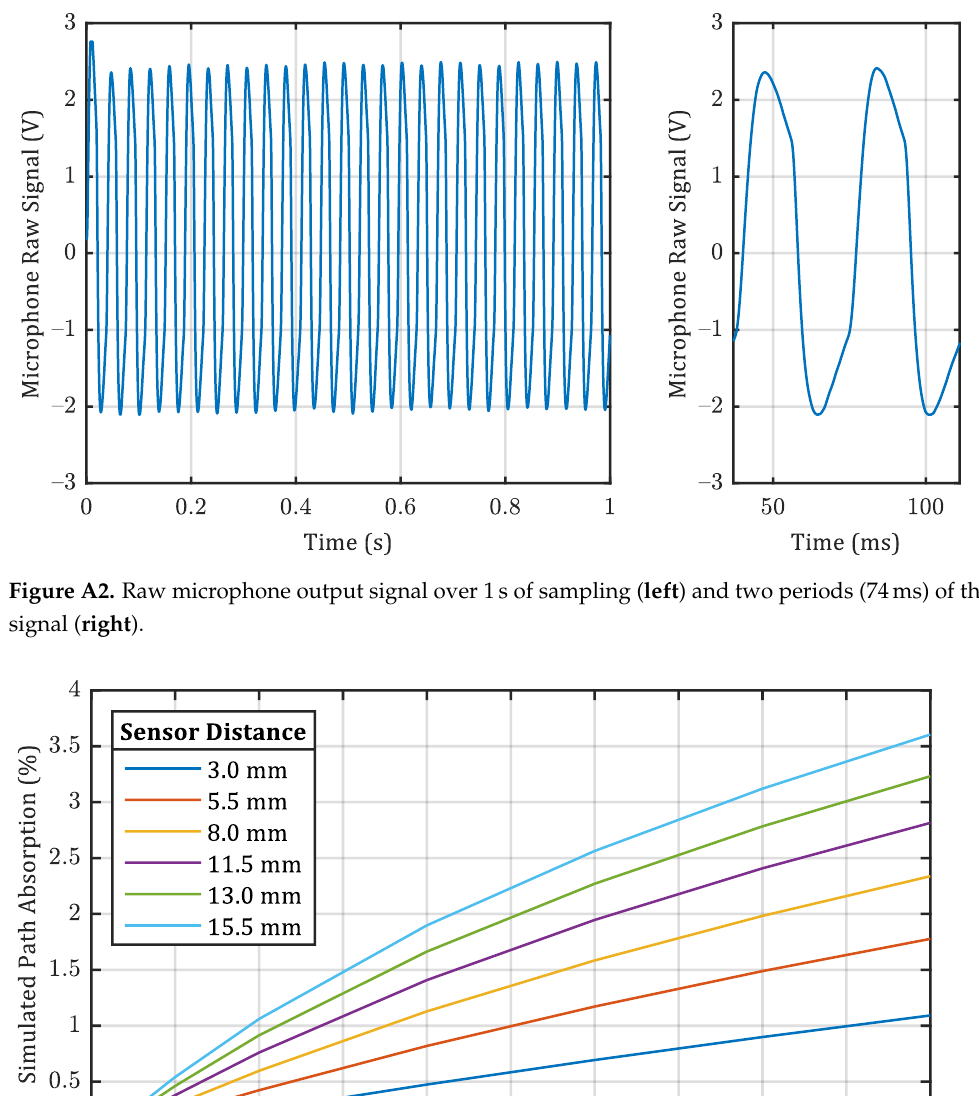
Figure A1. Background-compensated infrared transmission spectrum of the photoacoustic transducer. A characteristic dip at 4.26 µm indicates the presence of a high concentration of CO 2 inside the cavity of the device.